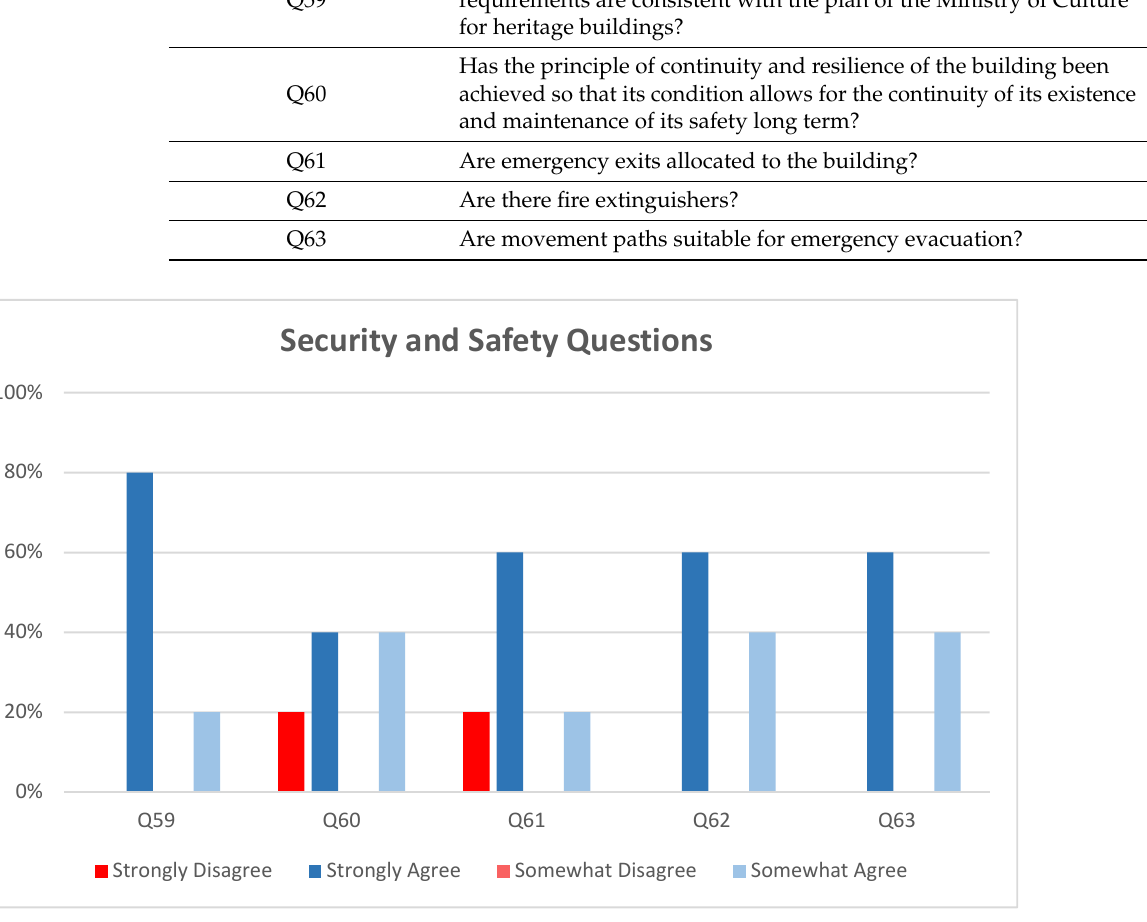
Figure 16. Results of the questions on security and safety .